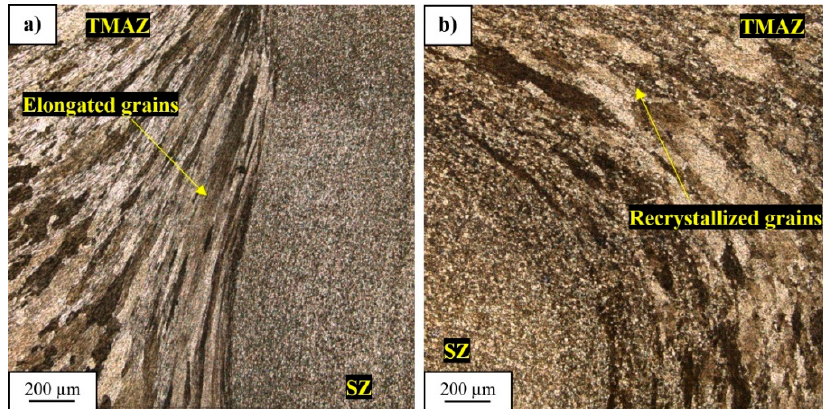
Figure 5. Microstructure of thermo-mechanically affected zone/stir zone (TMAZ/SZ) interface at the advancing side ( a ) and at the retreating side ( b ).